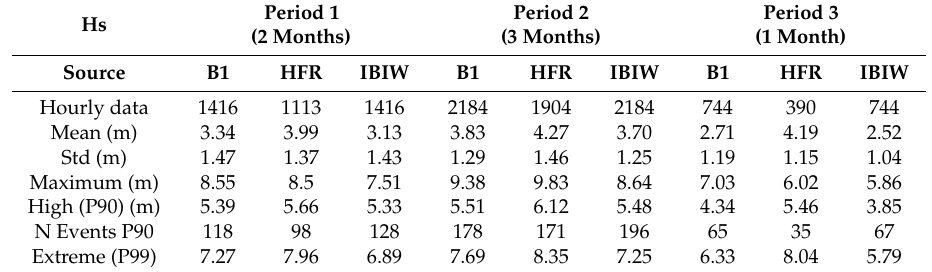
Table 2. Summary of statistical information about the wave height modeled and measured in the Galician region for three selected wintertime periods. N represents the number of hourly events.